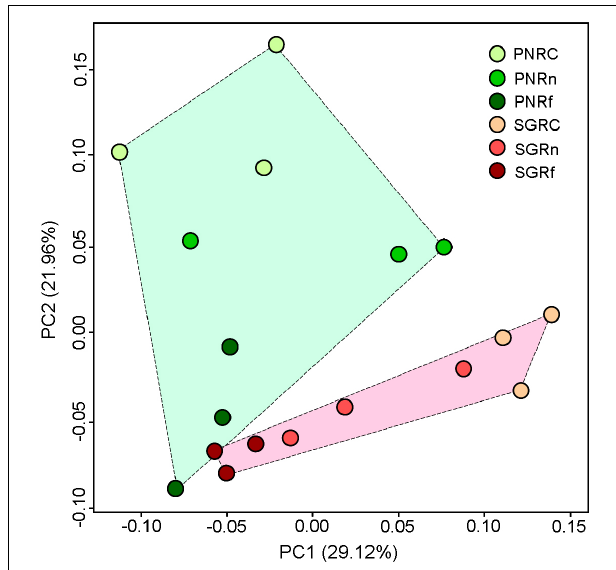
FIGURE 3 | Principal coordinates analysis of soil bacterial community (OUT abundance) as revealed by weighted UniFrac dispersion. PN, bahiagrass ( Paspalum natatum ); SG, stylo ( Stylosanthes guianensis ). RC, Rn, and Rf indicate root compartment, the near (0–5 mm) and the far (10–15 mm) rhizosphere.